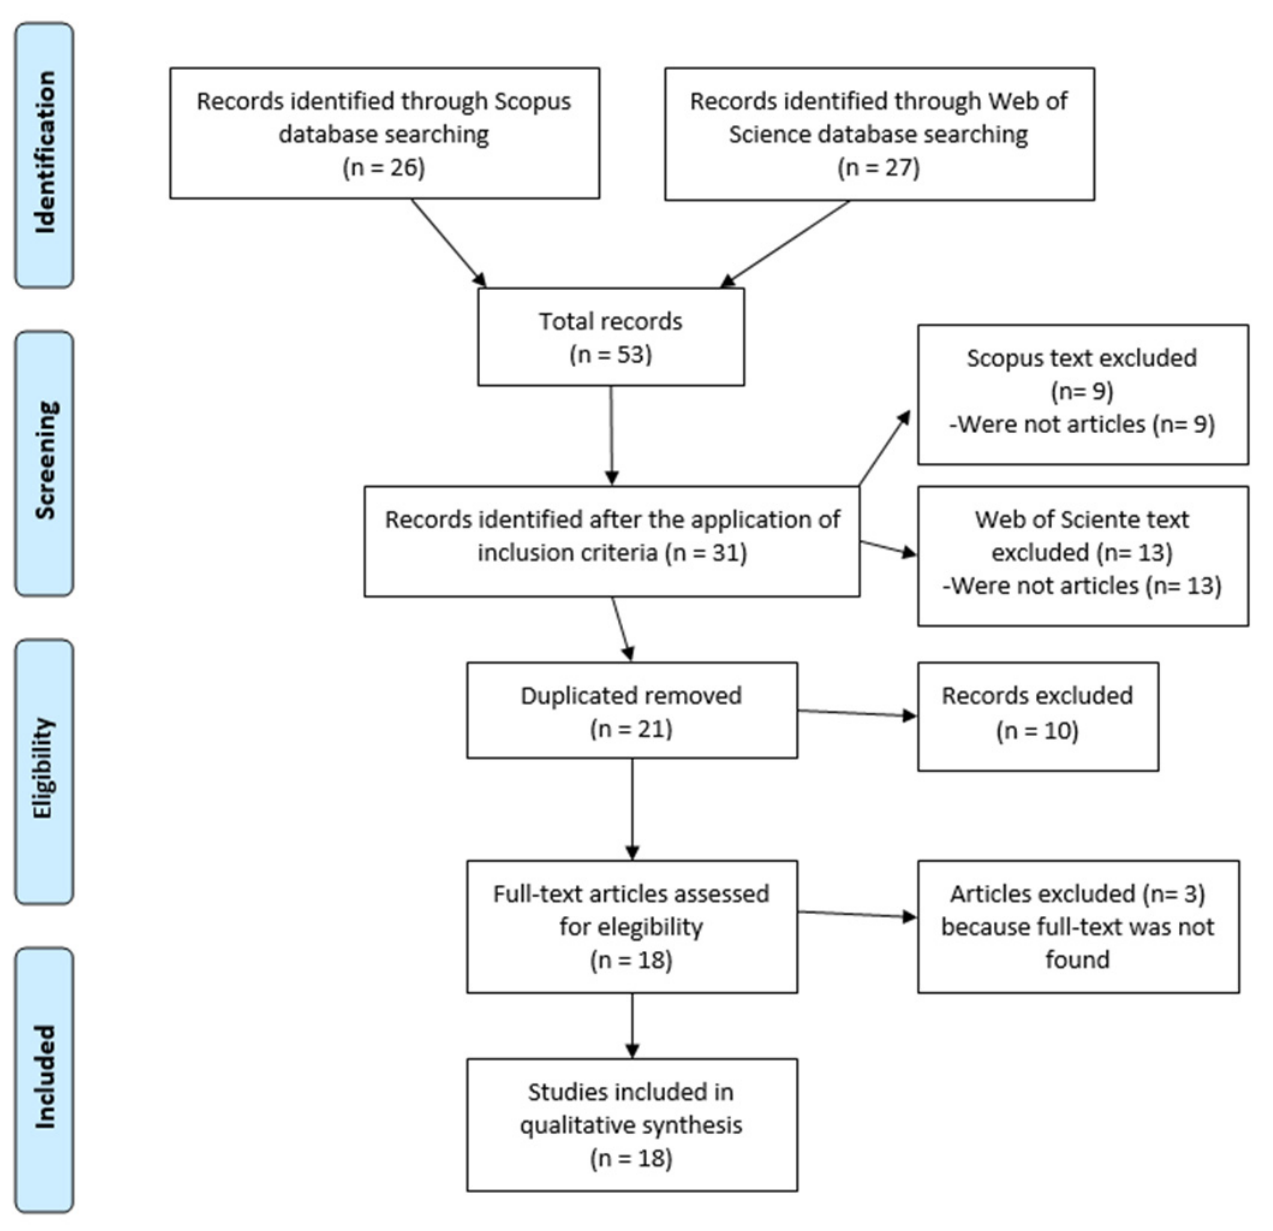
Figure 1. Flow diagram of PRISMA Systematic Review about “netiquette.”